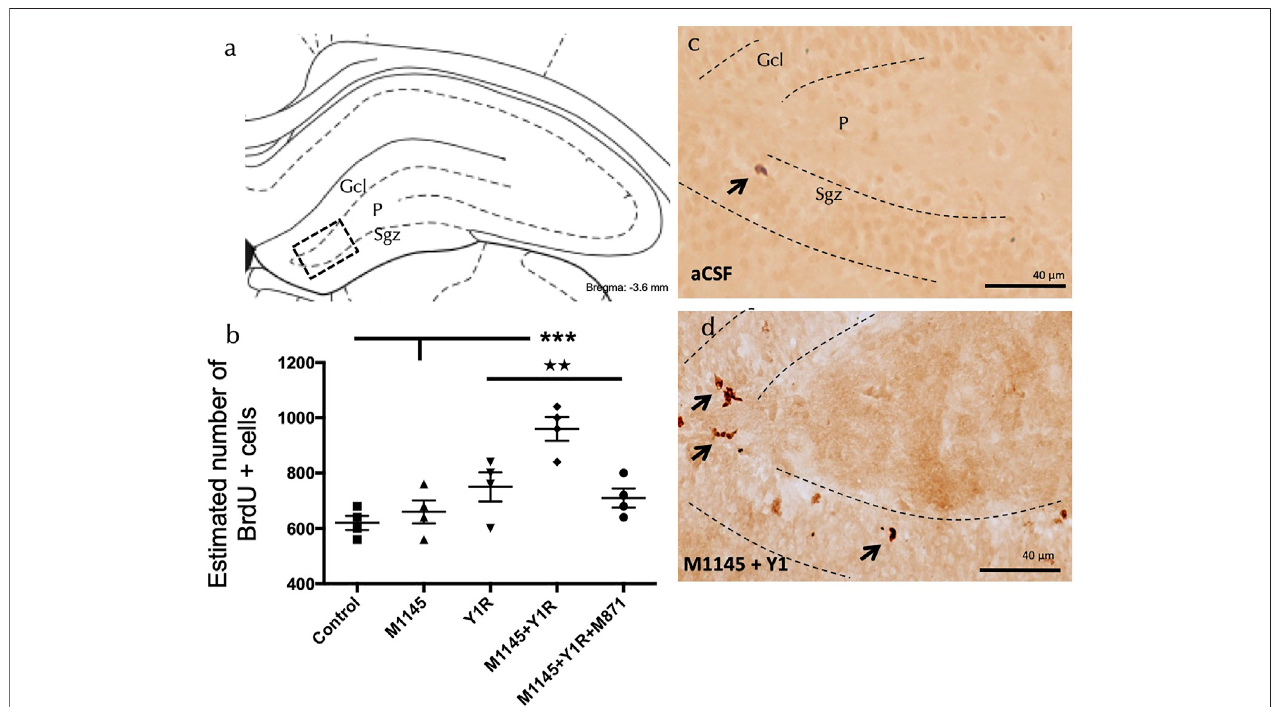
FIGURE 2 | 5 ′ -Bromo-2 ′ -deoxyuridine (BrdU) immunolabelling (BrdU+) in the dentate gyrus of the dorsal hippocampus, after the intranasal (in) administration of Galanin2receptoragonist(M1145)andY1Rreceptoragonist,eitheraloneorincombinationwithorwithouttheGAL2receptorantagonist(M871). (A,D) Themajorityof the BrdU-labeled cells were located in the subgranular zone (Sgz) of thedentate gyrus at theborder between the granular cell layer (Gcl) and the polymorphic layer (P)of the dentate gyrus in the dorsal hippocampus. They appeared to be nerve cells forming clusters of 3 – 4 cells. (Bregma: -3.6 mm; according to the Paxinos and Watson stereotaxic atlas (1986)). (B) Quanti fi cation of total BrdU IR cells in the dentate gyrus of the dorsal hippocampus. Data represent mean ± SEM to show the differencesbetweengroupsafteradministrationofaCSF,M1145,Y1Ragonist[Leu 31 -Pro 34 ]NPY,orthecoadministrationofbothpeptideswithorwithoutM871.M1145 andtheY1RagonistcoadministrationincreasedthenumberofcellswithBrdUexpressioninthedorsalhippocampuscomparedtothelackofeffectsofthetwopeptides given alone and the aCSF group. Furthermore, this effect was blocked by GALR2 antagonist M871. *** p < 0.001 vs. control and M1145; ++ p < 0.01 vs. Y1R and M1145 + Y1R + M871 according to one-way ANOVA (F4, 15 = 10.96, p < 0.001) followed by Newman-Keuls post-hoc test. Inter-group comparisons are indicated by the vertical lines from the horizontal line above bars. N = 4 in each group. M1145 and Y1R agonist coinjection (D) increased the BrdU immunolabelling in Sgz in the dentate gyrus compared with the control group (C) . Arrows indicate examples of clusters of BrdU positive nerve cells. Dashed lines outline the Gcl of the dentate gyrus. Abbreviations: Control = Distilled water; M1145 = Galanin 2 receptor agonist 132 µg; Y1R = Y1R receptor agonist [Leu 31 -Pro 34 ]NPY 132 µg; M1145 + Y1R = Coadministration of M1145 and Y1R; M1145 + Y1R + M871 = Co-administration of M1145, Y1R and GALR2 antagonist M871 132 µg. Treatments were performed 24 h before brain processing; see material and methods for further